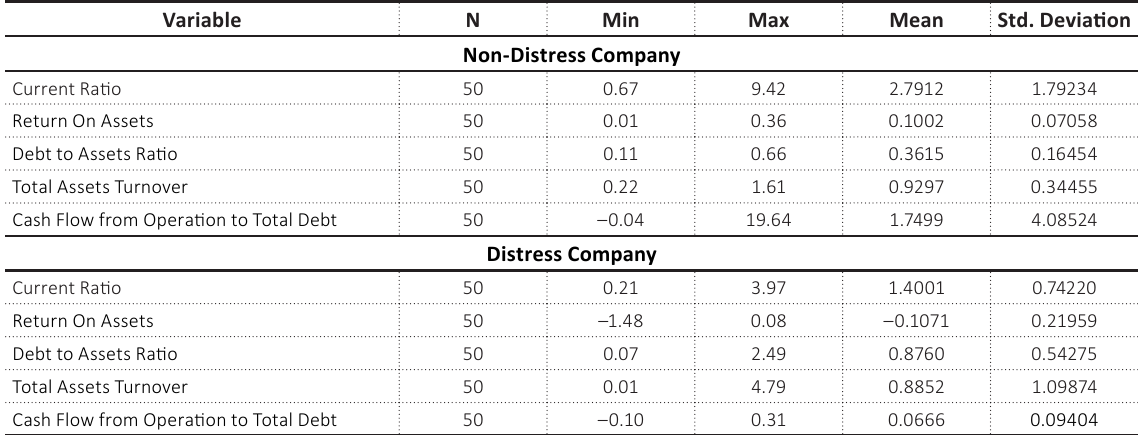
Table 3. Descriptive statistics of training data sample